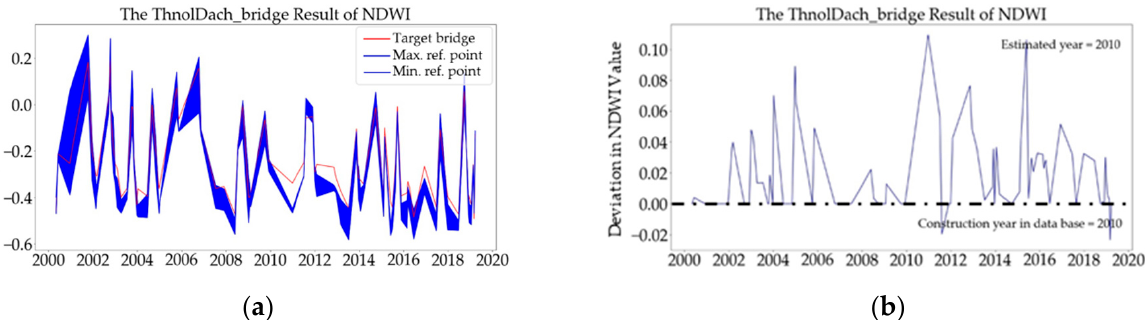
Figure 21. ( a ) NDWI results for the Thnol Dach bridge from which it is estimated that the bridge was constructed in 2010; ( b ) re-visualization of ( a ) showing the NDWI difference; a clear change is apparent.